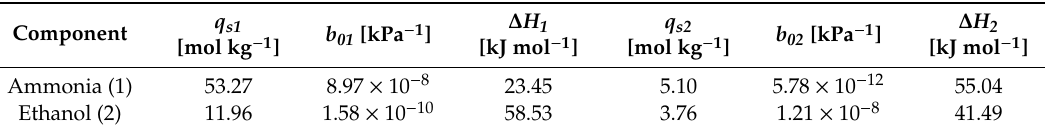
Table 4. Regressed Parameters of the Dual-Site Langmuir Model for Ammonia and Ethanol on SRD 1352 / 3. Equilibrium Data are from